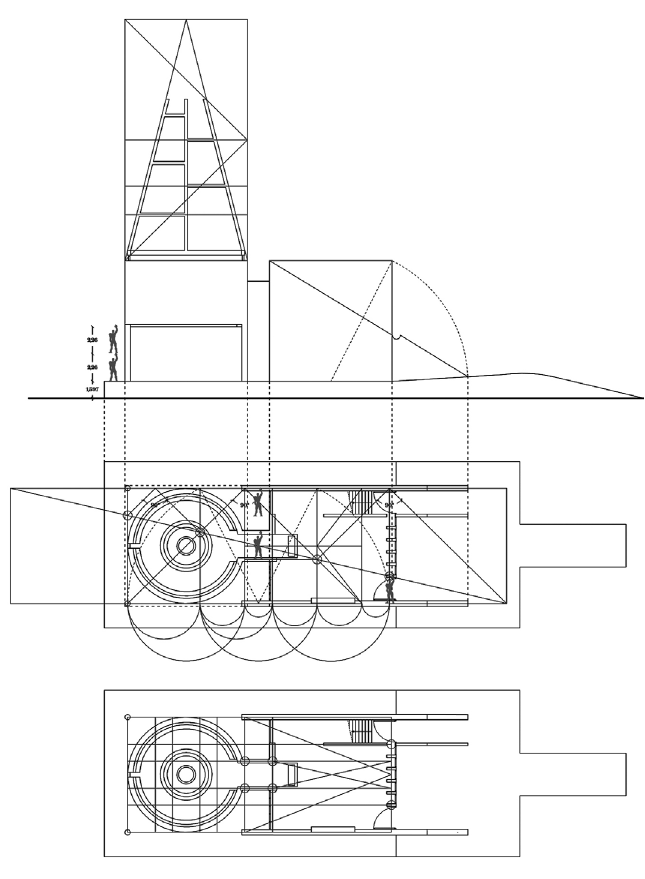
Fig. 2 A. Tortorici, Graphical analysis of the plants and of the side elevation of the church for Bologna,